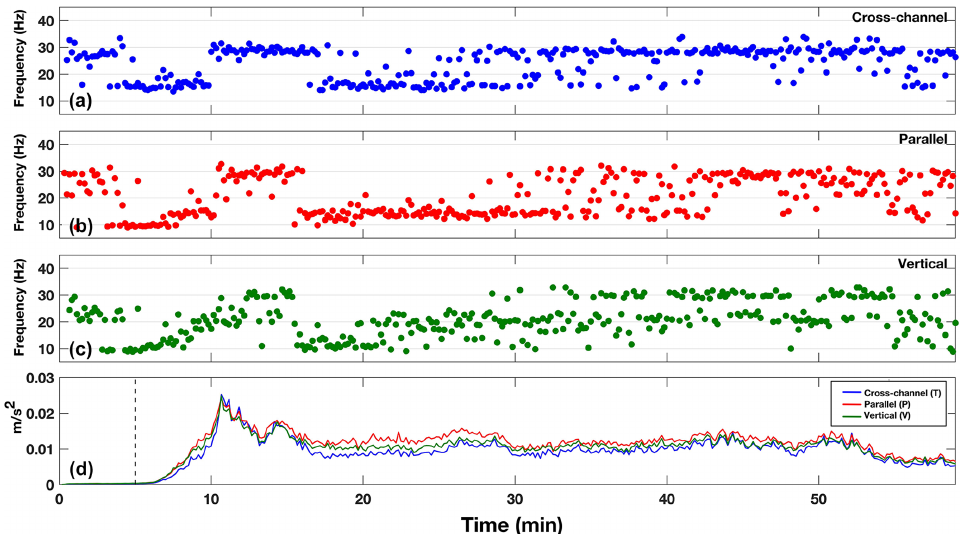
Figure 4. Peak spectral frequencies for TRAN (28km from source) for (a) cross-channel (blue), (b) flow-parallel (red), and (c) vertical (green) directions. Bottom row (d) depicts the rms amplitude of the lahar color coded to the same colors as the PSF. The dashed vertical line marks the timing of the lahar front passing the monitoring station. All PSFs and rms amplitudes were calculated using 10s time